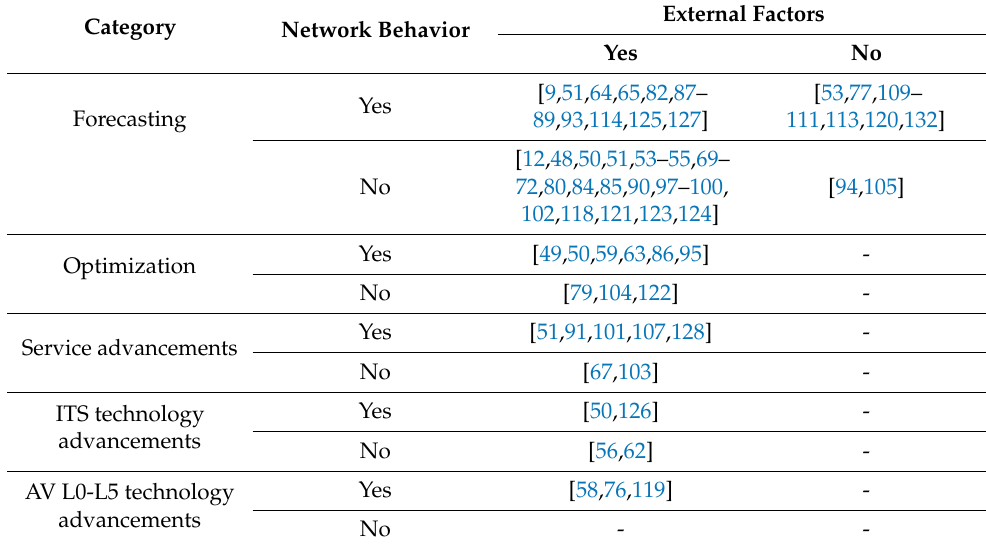
Table 4. STS application areas (spatial–external